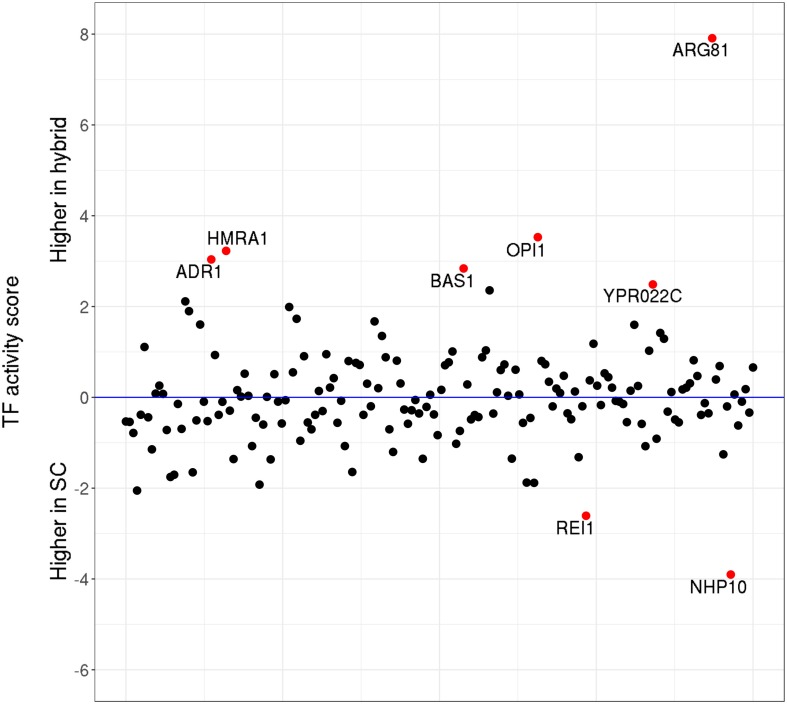
Transcription factor (TF) activity scores. Relative activity levels between Saccharomyces cerevisiae parental and the hybrid counterparts. Red dots highlight the TFs which significantly (p < 0.05) changed their activity levels upon hybridization.